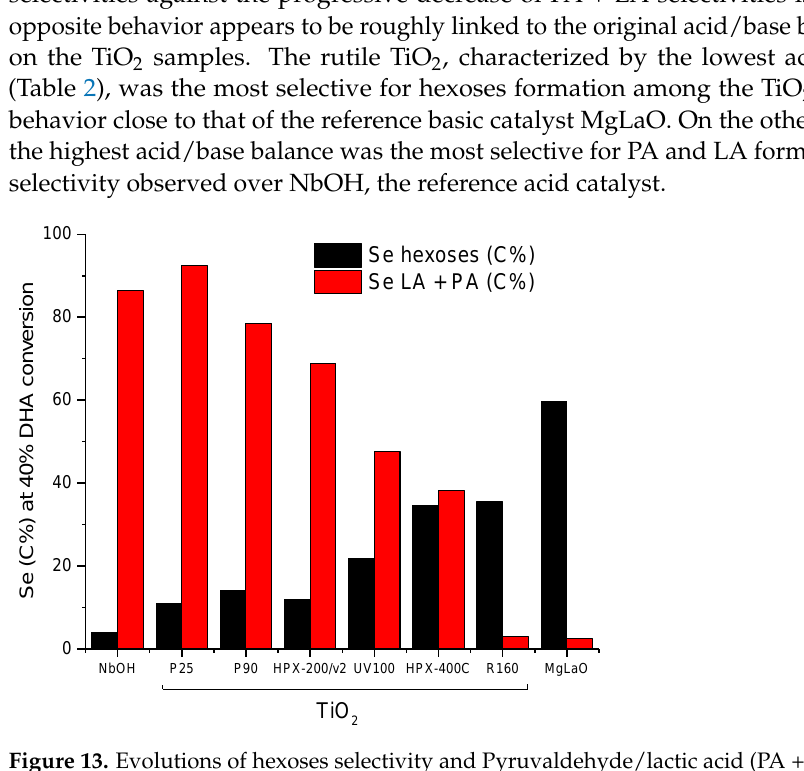
Figure 13. Evolutions of hexoses selectivity and Pyruvaldehyde/lactic acid (PA + LA) selectivities at 40% DHA conversion as a function of the TiO 2 (cid:48) s acid/base balance. Comparison with the reference 40% DHA conversion as a function of the TiO 2 ′ s acid/base balance. Comparison with the reference solid acid, NbOH, and the reference solid base, solid acid, NbOH, and the reference solid base, MgLaO.